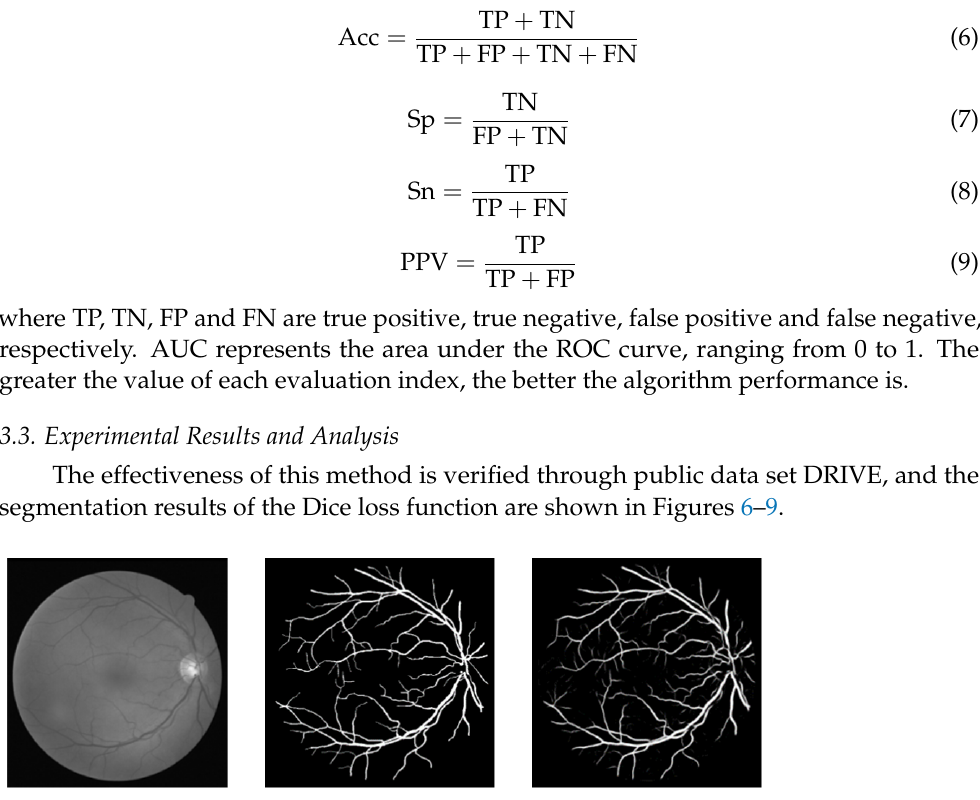
( a ) ( b ) ( c ) Figure 7. Second group of segmentation results ( a ) original image ( b ) gold standard image ( c ) seg- mentation results of this paper. ( a ) ( b ) ( c ) Figure 8. Third group of segmentation results ( a ) original image ( b ) gold standard image ( c ) seg- mentation results of this paper. ( a ) ( b ) ( c ) Figure 9. Fourth group of segmentation results ( a ) original image ( b ) gold standard image ( c ) seg- mentation results of this paper. To prove the feasibility of the proposed method, these results were compared with manual segmentation and segmentation in the literature. As shown in Figure 10, four im- ages were randomly selected from the test set. Images labelled as (a) are the original im- age, (b) are the gold standard image, (c) are the segmentation result in [22], and (d) are the segmentation result of the algorithm in this paper. The white ellipse region is the result of fine segmentation. As can be seen from the figure, the proposed algorithm can achieve a good segmen- tation effect for both normal retinal vessels and pathological retinal vessels, more micro-